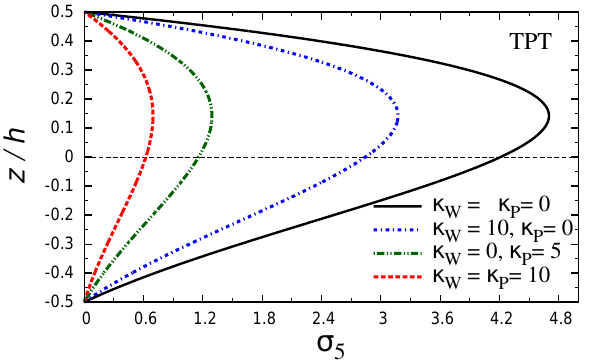
Figure 9: Through-the-thickness distributions of transverse shear stress σ 5 of the EG thick rectangular plate on elastic foundations ( a = 4 h , b = 3 a , k = 1.5) .